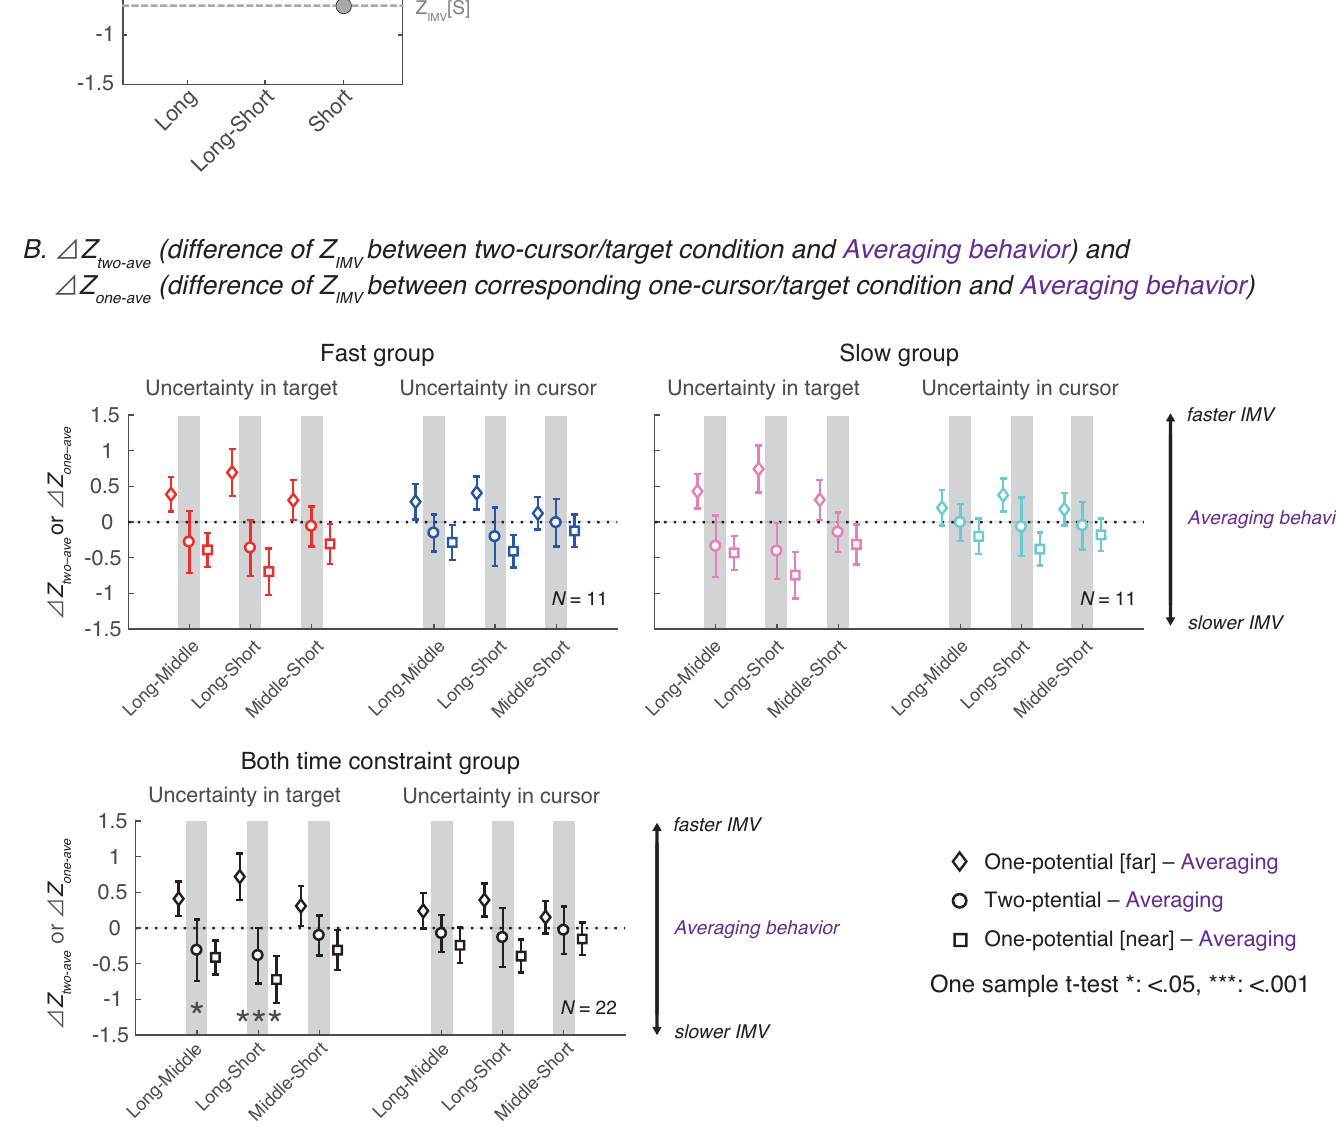
Fig 4. Difference between the estimated averaging behavior and the observed behavior in each condition. (A) Definition of averaging behavior and Δ Z two − ave (difference between the averaging and observed behaviors). The averaging behavior was defined as the average value of Z IMV in the two corresponding one-potential conditions (a purple line and circle). The Δ Z two − ave (an orange arrow) was defined as the difference between the averaging and observed behaviors (a yellow line and circle). (B) Inter-participant means of the Δ Z (circles) and Δ Z (diamonds and squares) in the fast group (upper-left panel), slow group (upper-right panel), two − ave one − ave and both time constraint group (lower panel) were shown. One-sample t -tests with Bonferroni correction on Δ Z two − ave in each condition was conducted using the data pooled from both time constraint group. Besides, one-sample t -tests on Δ Z averaged across distance conditions for each uncertainty condition were conducted two − ave